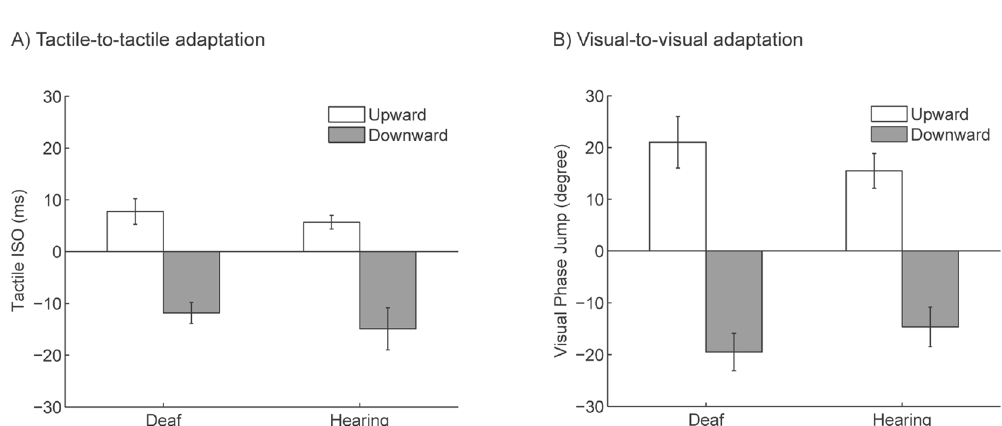
Figure 8. Unisensory aftereffects measured by PSE in Experiment 2. (Panel A ) shows the average of tactile PSEs after adaptation to tactile motions, while (Panel B ) shows the average of visual PSEs after adaptation to visual motions. PSE after the upward and downward adaptation are shown respectively in white and grey. Error bars represent one standard